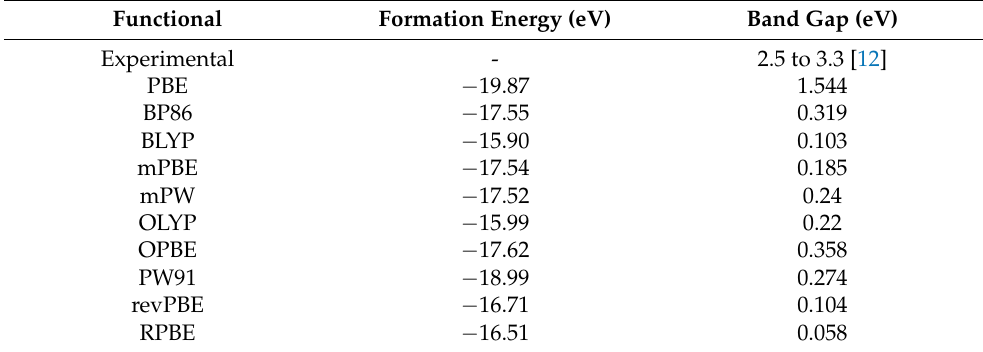
Table 1. A comparison of formation energy and band gap of monolayer SnO was calculated using different GGA functional. Functional Formation Energy